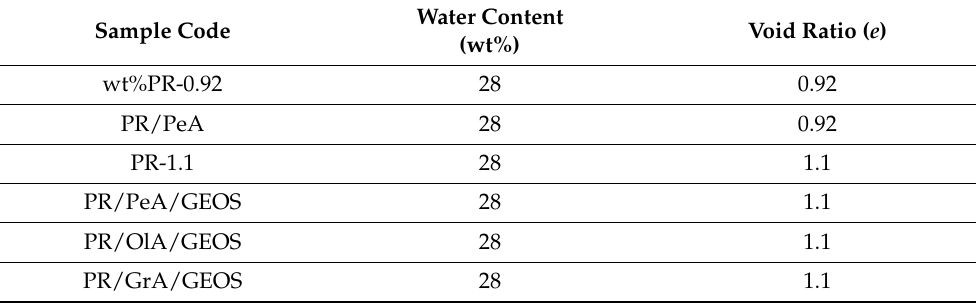
Table 2. Samples tested for